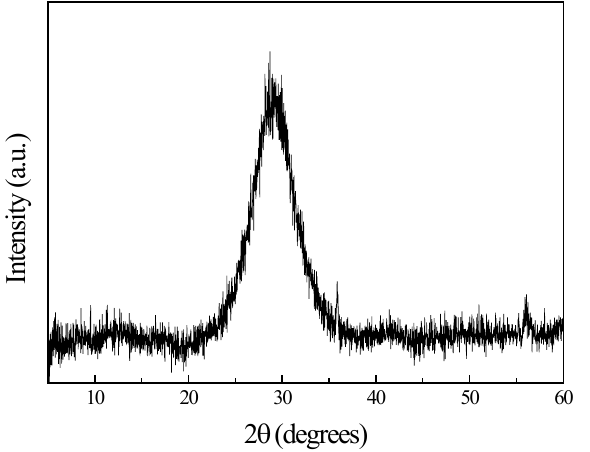
Figure 1. XRD pattern of bismuth titanium oxide thin film without annealing